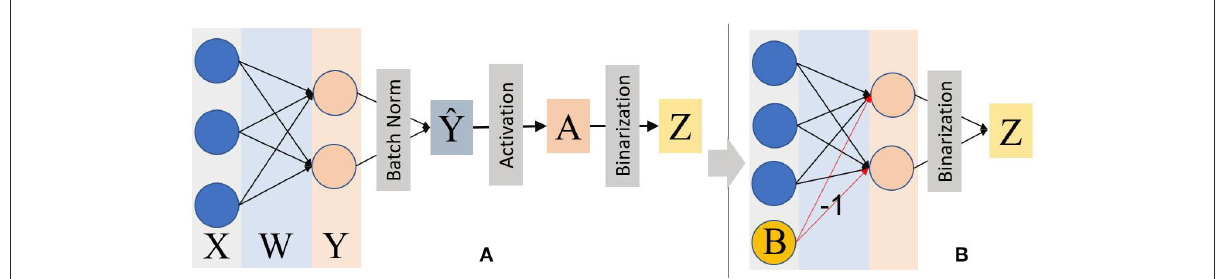
FIGURE2 (A) The binarized CNN forward propagation with the batch norm and adaptive activation function before simplification. The activation function tanh is used considering its feature of sign invariance to inputs. (B) The simplified inference process on the PPA device by mathematically